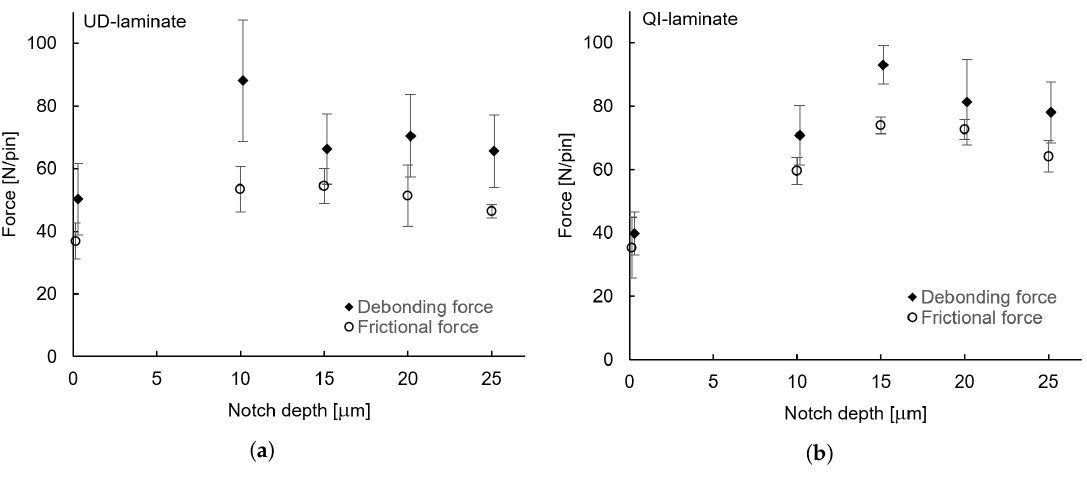
Figure 7. Mean values and corresponding standard deviation values of debonding and frictional forces measured during z-pin pullout of unnotched and circumferentially notched z-pins with circular notch design and different notch depths in ( a ) unidirectional and ( b ) quasi-isotropic laminate